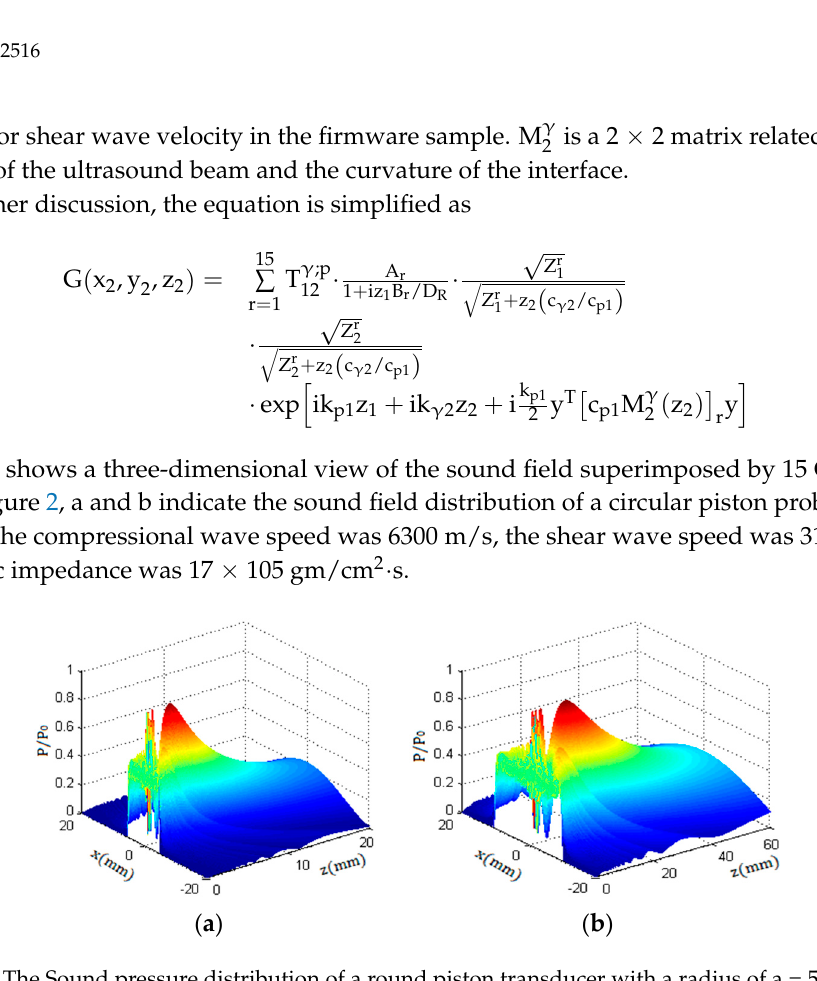
Figure 2. The Sound pressure distribution of a round piston transducer with a radius of a = 5 mm and 10 mm in a solid medium. ( a ) a = 5 mm; ( b ) a = 10 mm.